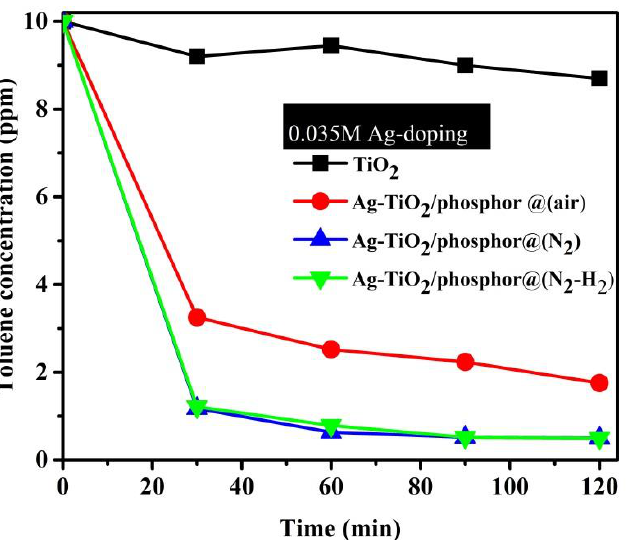
Figure 9. Photocatalytic degradation of toluene with the 0.035M Ag-doped TiO 2 /phosphor beads over visible light irradiation.